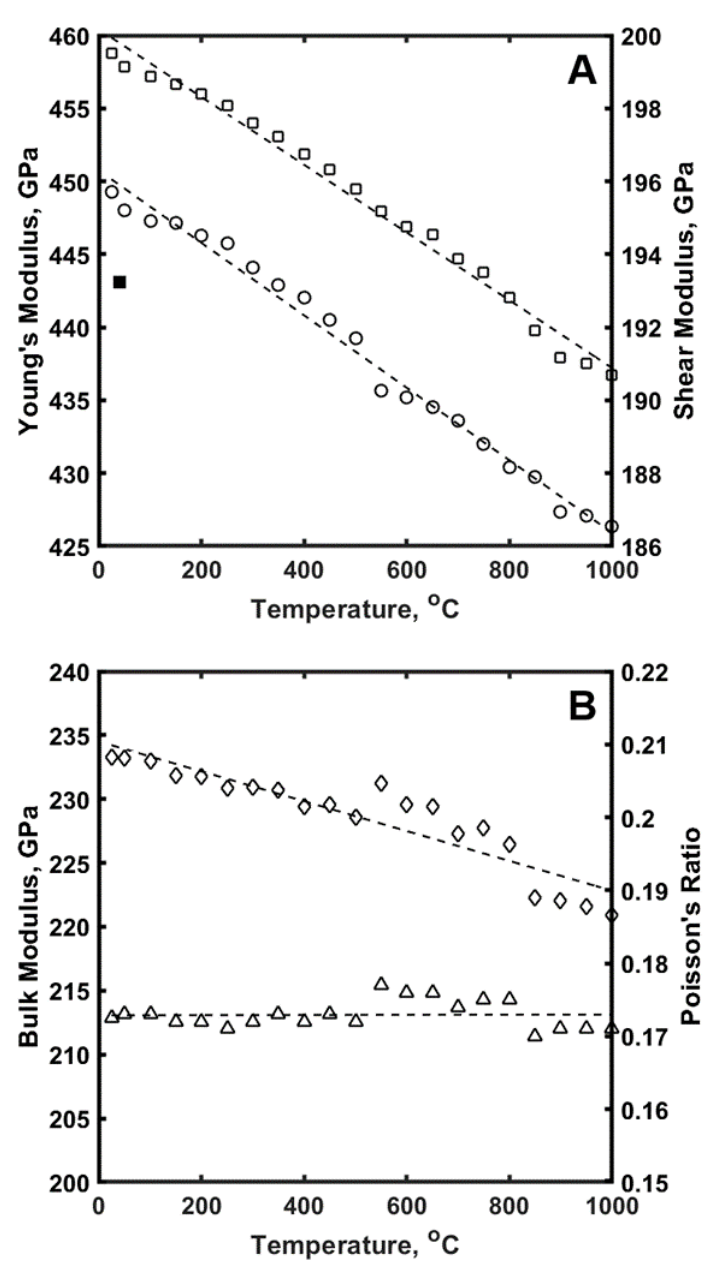
Figure 5. Elastic properties of B 4 C measured by Resonance Ultrasound Spectroscopy (RUS). ( A ) Young’s modulus (□) and Shear modulus ( ○ ) as a function of temperature: ( B ) Bulk modulus (◊) and Poisson’s ratio (∆) as a function of temperature. Young’s modulus ( ∎ ) measured by IE.